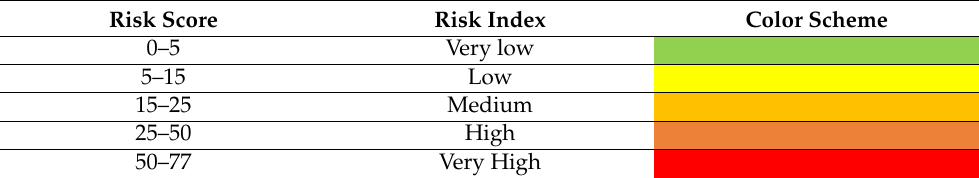
Table 2. Domain of discourse for risk factors.